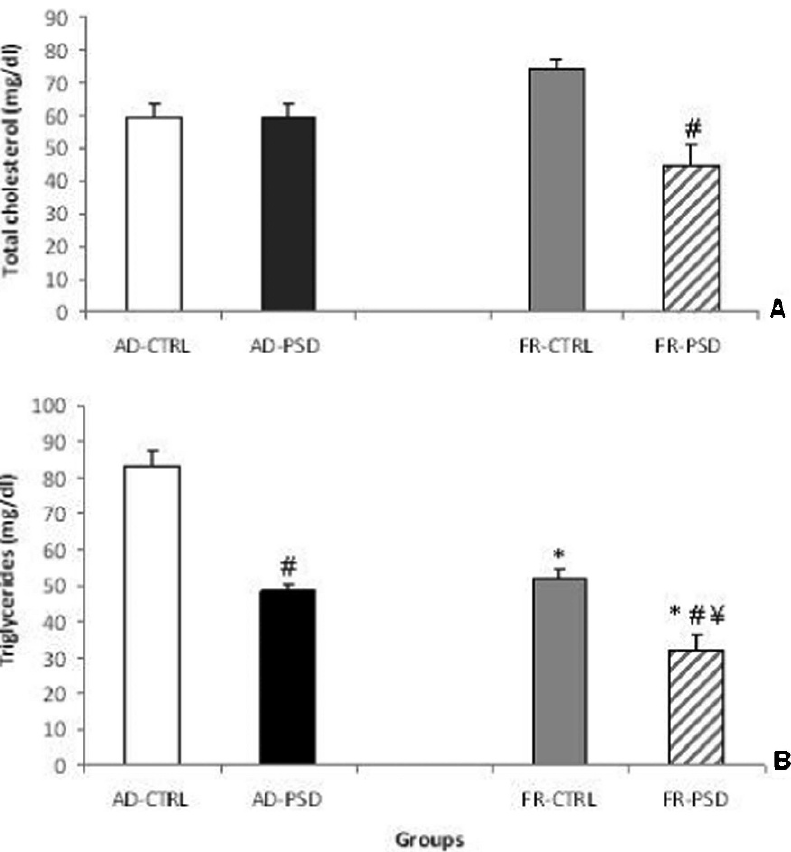
Figure 1 - Effects of food restriction (FR) or ad libitum diet (AD), either paired or unpaired with paradoxical sleep deprivation (PSD), on the total cholesterol (panel A) and triglyceride levels (panel B) in male rats. *Significantly different from the AD-CTRL group, ¥ Significantly different from the AD-PSD group and # Significantly different from the respective control